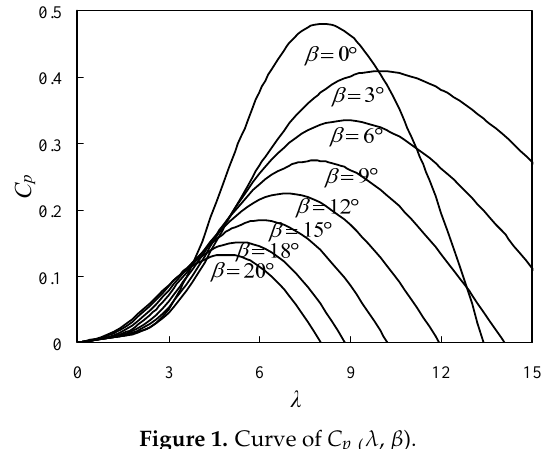
Figure 1. Curve of C p ( λ , β ).